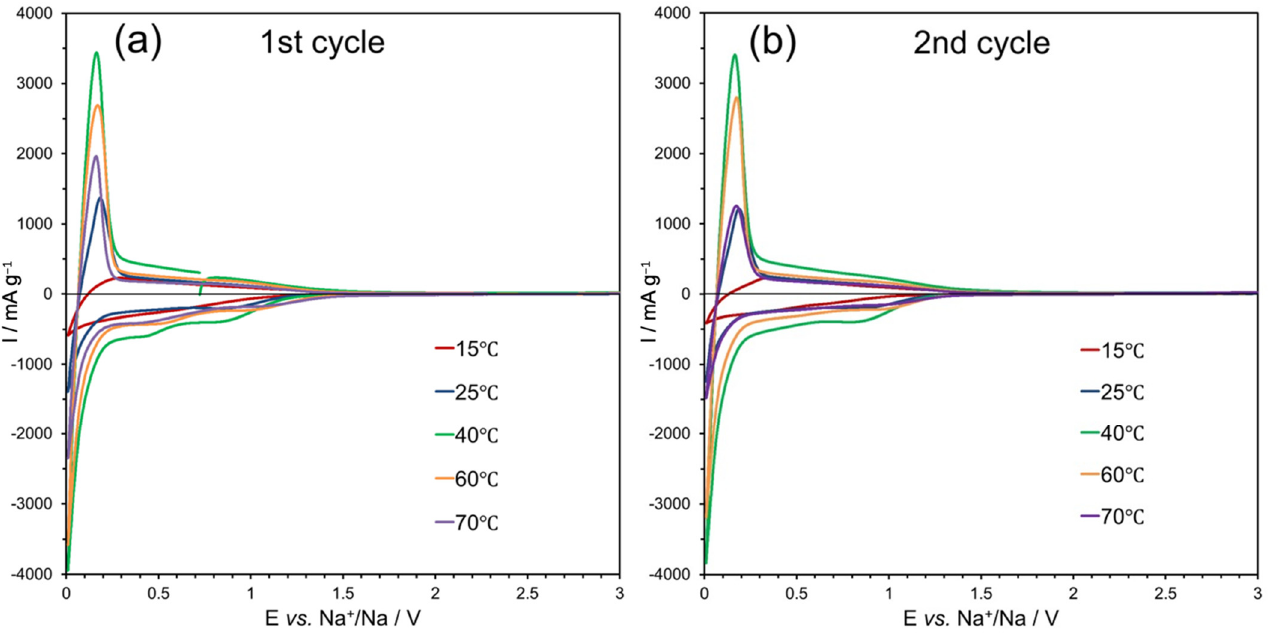
Figure 6. CV profile of HC at temperatures from 15 to 70 °C at 1 mV s − 1 scan rate between 3 and 0.01 V vs. Na + /Na ( a ) 1st cycle and ( b ) 2nd cycle.